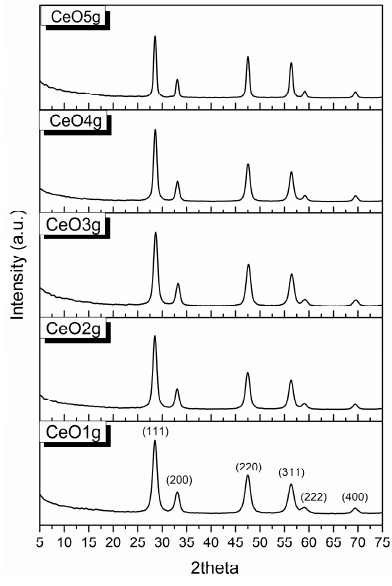
Figure 2. XRD patterns of CeO 2 nanoparticles.